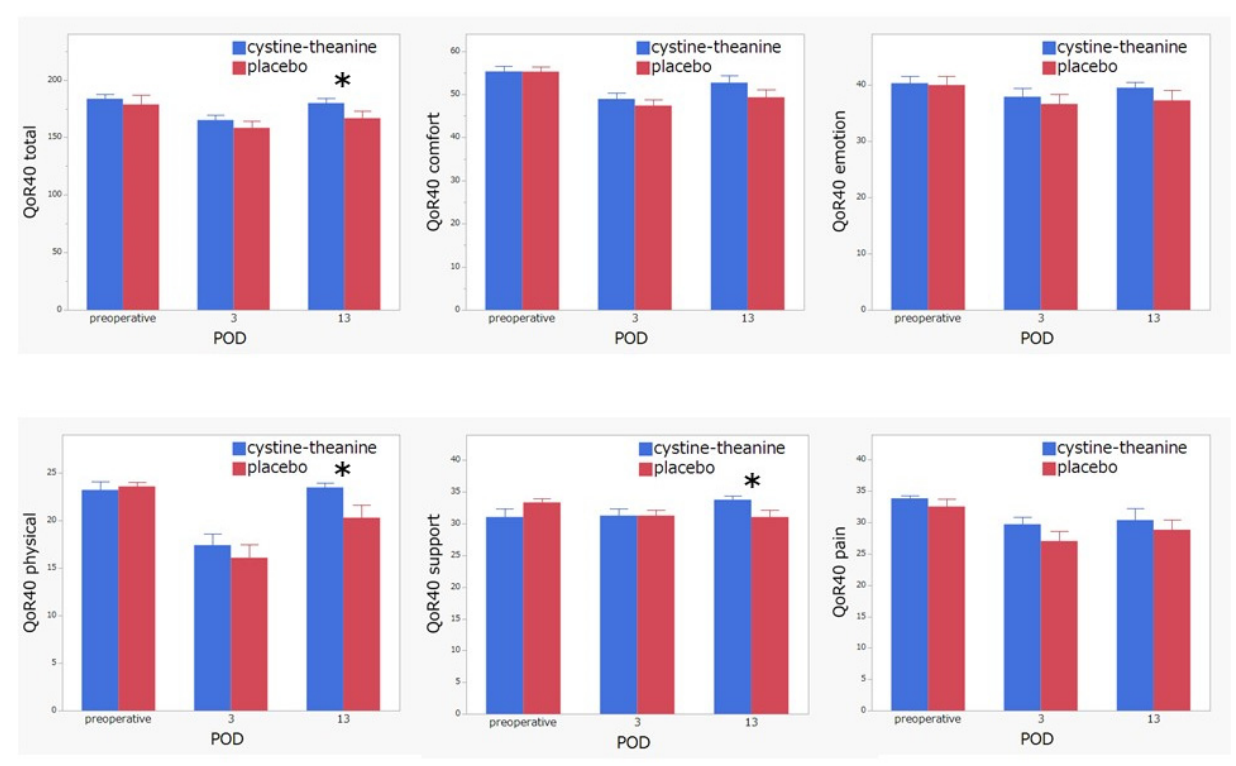
Figure 6. QoR-40. Total score, physical independence, and patient support on POD 13 in the CT group were significantly higher than those in the placebo group. * p < 0.05.